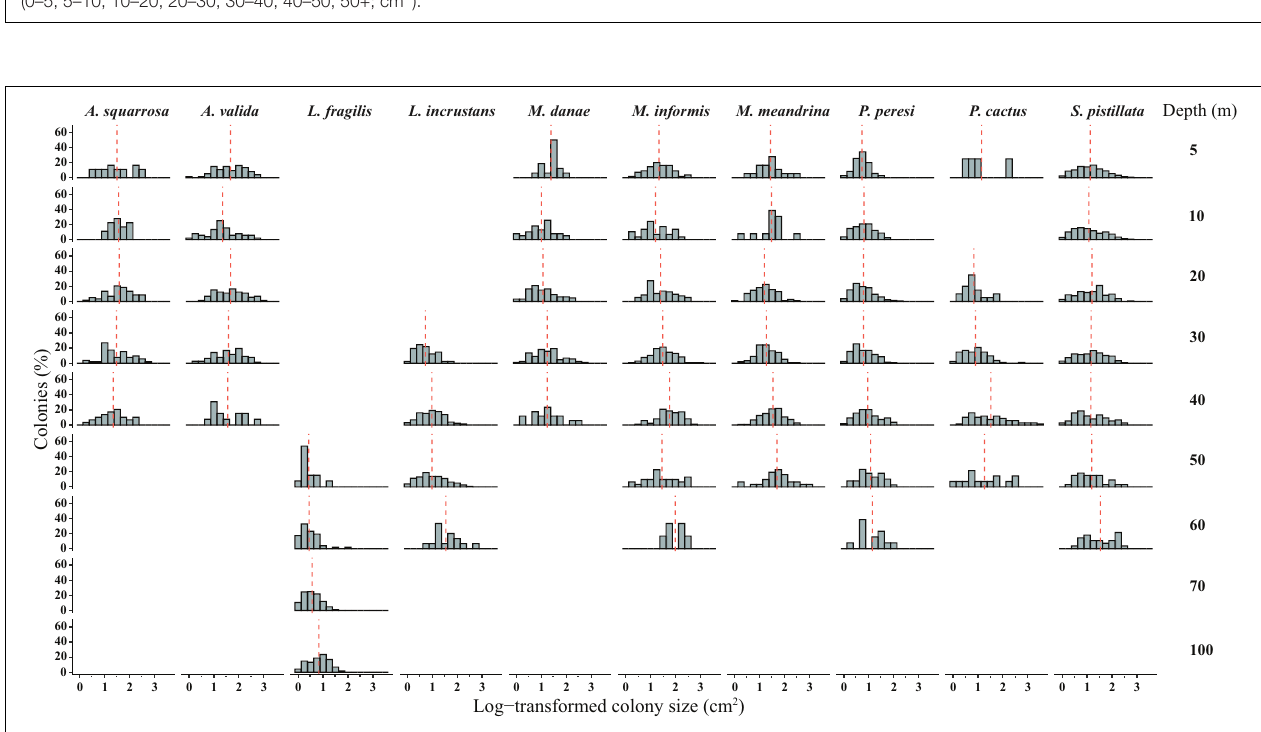
FIGURE 3 | Size-frequency distributions (SFDs) based on untransformed size classes (cm 2 ) of six morphological categories: branching, corymbose, digitate, encrusting, laminar and massive across depths (5, 10, 20, 30, 40, 50, 60, 70, and 100 m; pooled among sites). Data were distributed among seven size classes